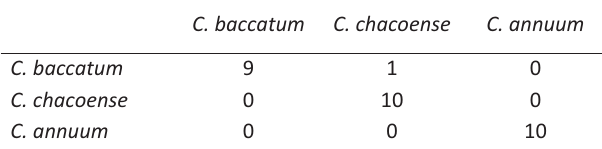
Table 4 ­ Confusion Matrix derived from the Random tree analy­ sis from the aromatic profiles of the pepper species obtained using a decision tree learning